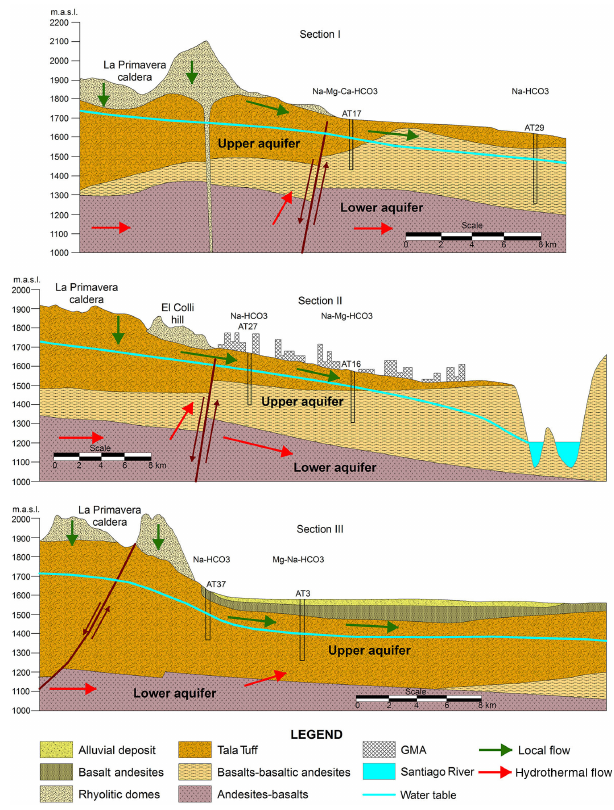
Figure 3. Cross sections indicated in Fig. 2 and considering hydro- geological settings and water types of selected